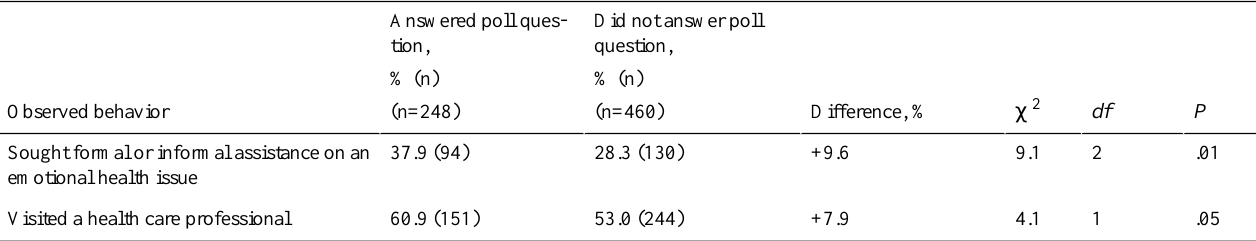
Table 4. Poll users versus